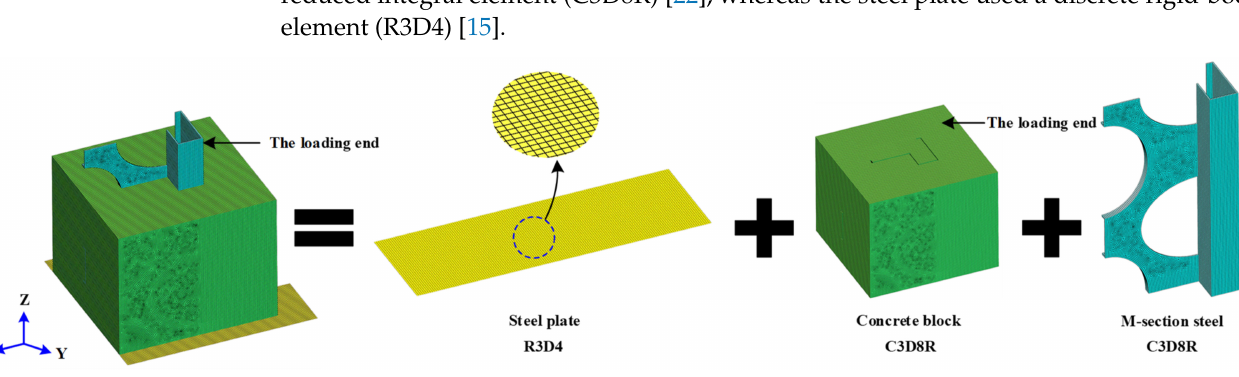
Figure 17. Finite element type and